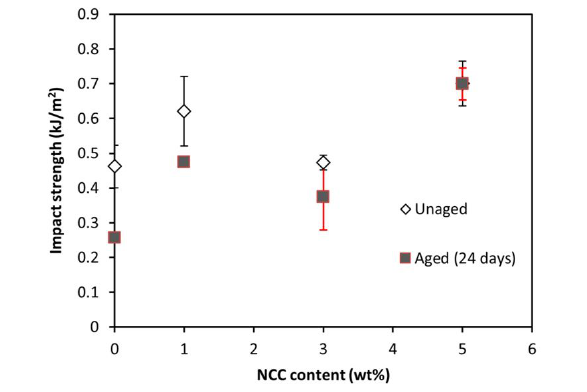
Fig. 5. The impact strength of NCC/UPR composites at various NCC content and ageing